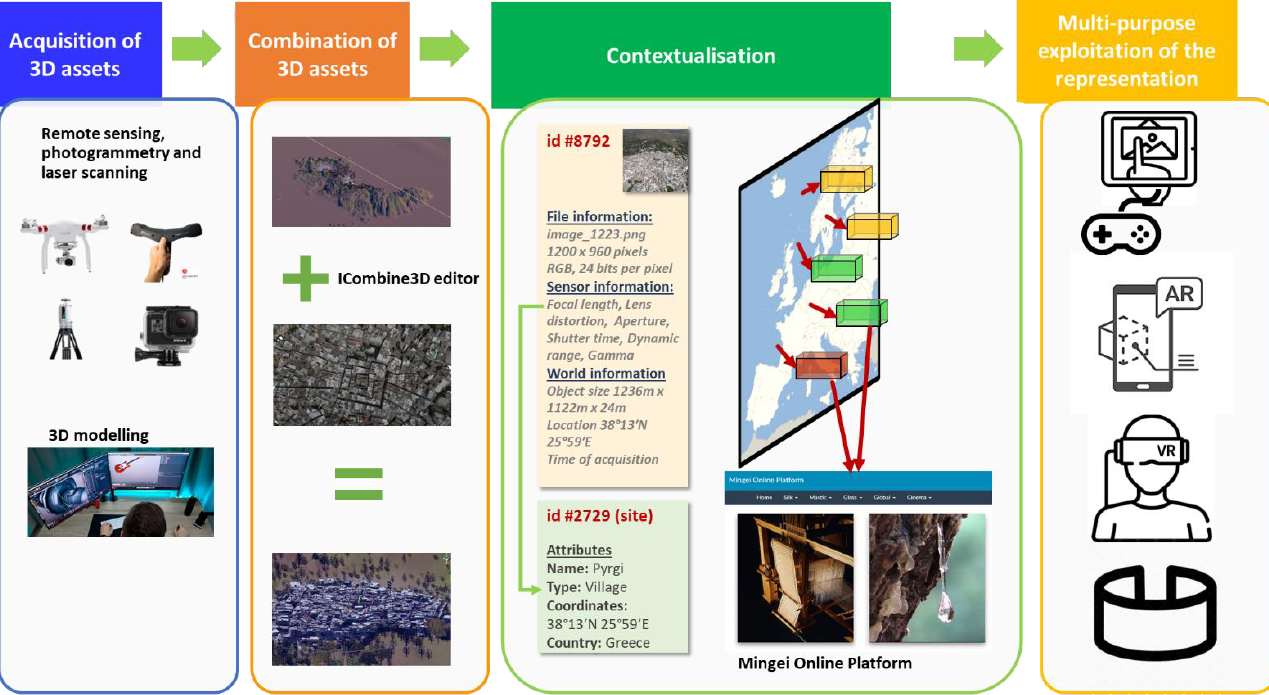
Figure 1. Illustration of the proposed approach.